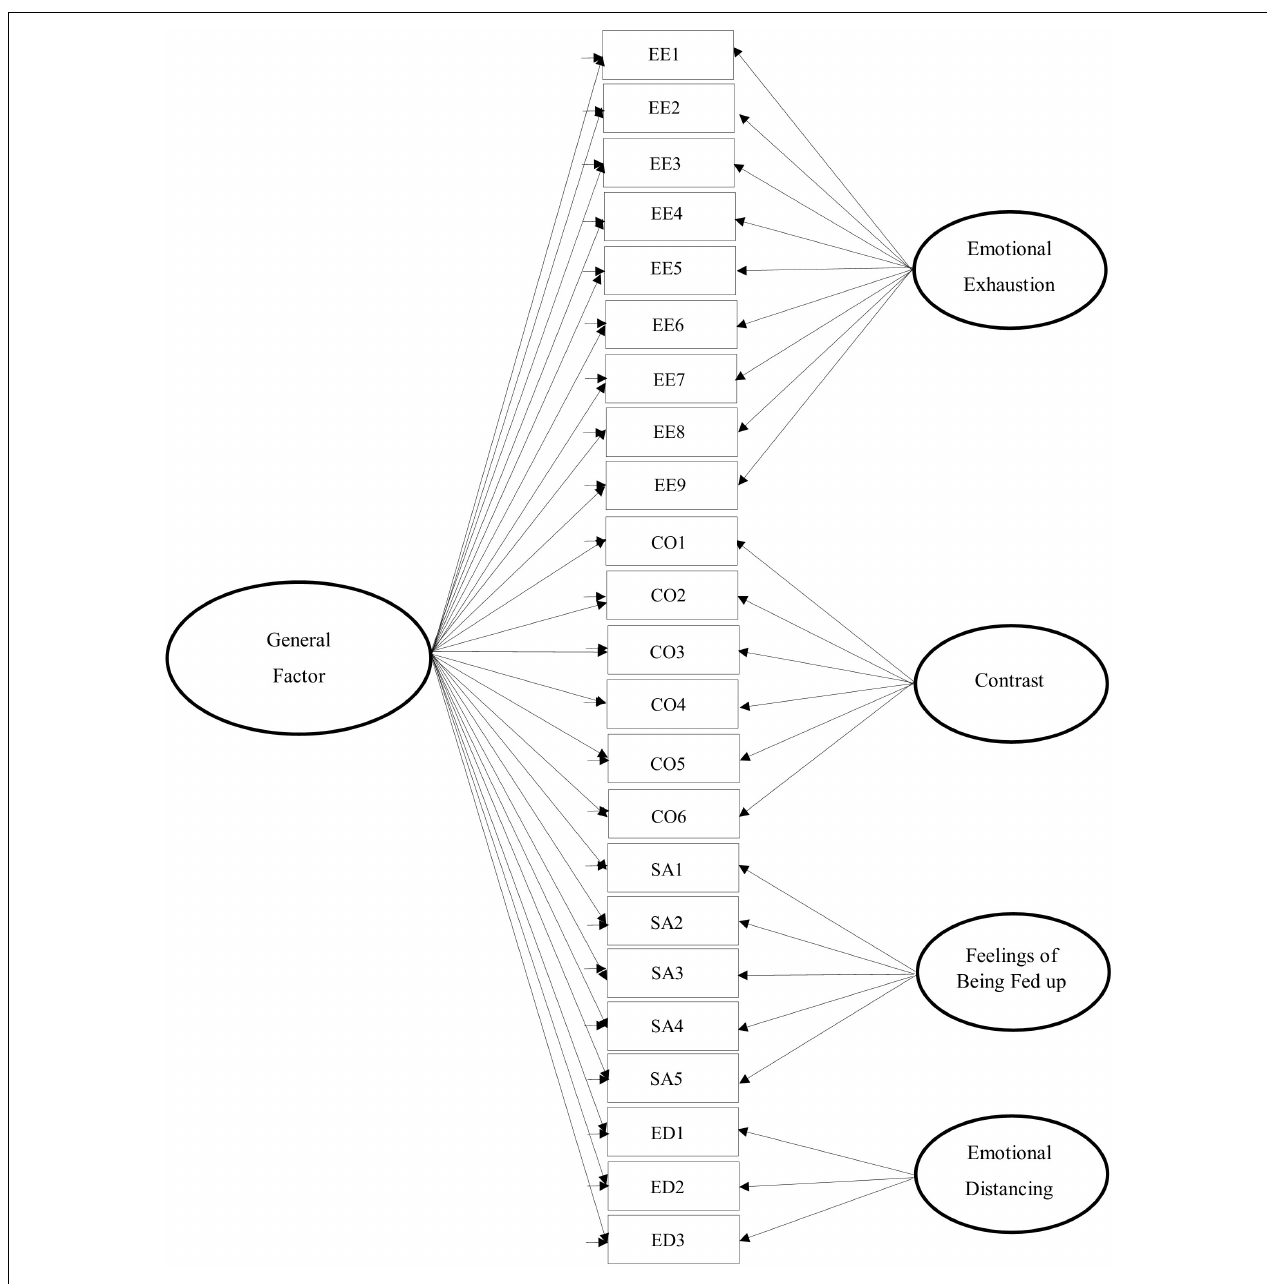
FIGURE 1 | The conceptual bifactor model of parental burnout.